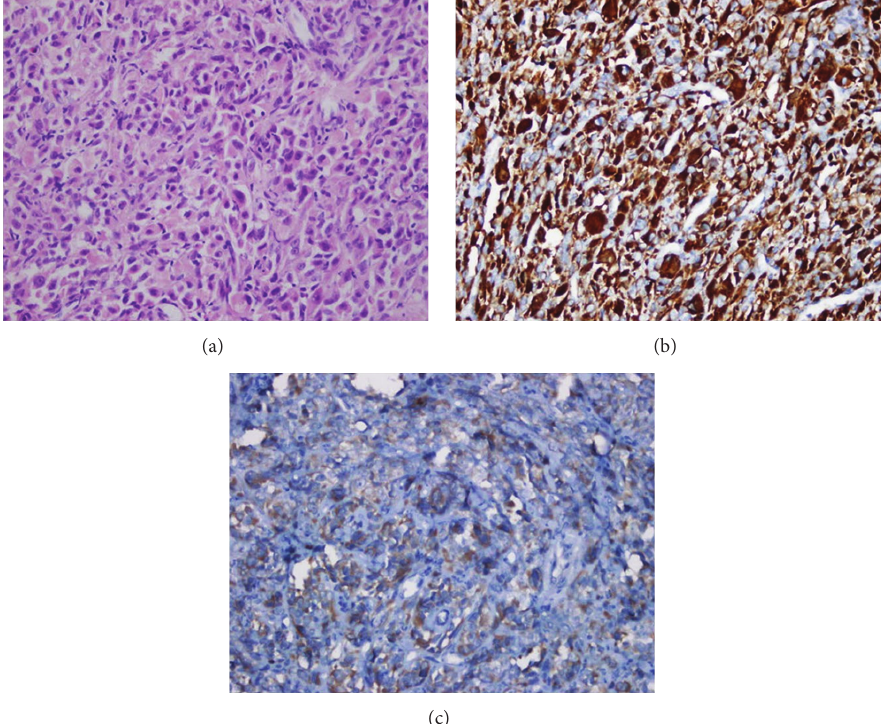
Figure 1: (a) Photomicrograph demonstrating significant pleomorphism and variable dimension of rhabdomyoblastic cells with abundant eosinophilic cytoplasm and eccentric nuclei (HE × 400). (b) The neoplastic cells showing strong desmin positivity by immunohistochemical reaction (desmin × 400). (c) The neoplastic cells with nuclear staining for myogenin (myogenin × 400).